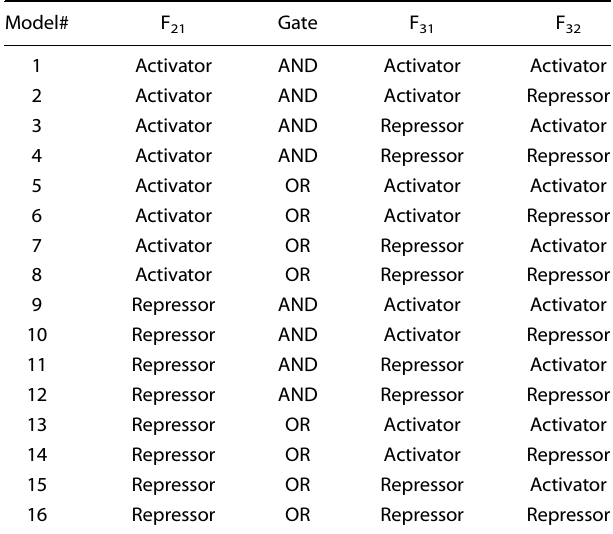
Table 1. Structure of each of the 16 non-linear